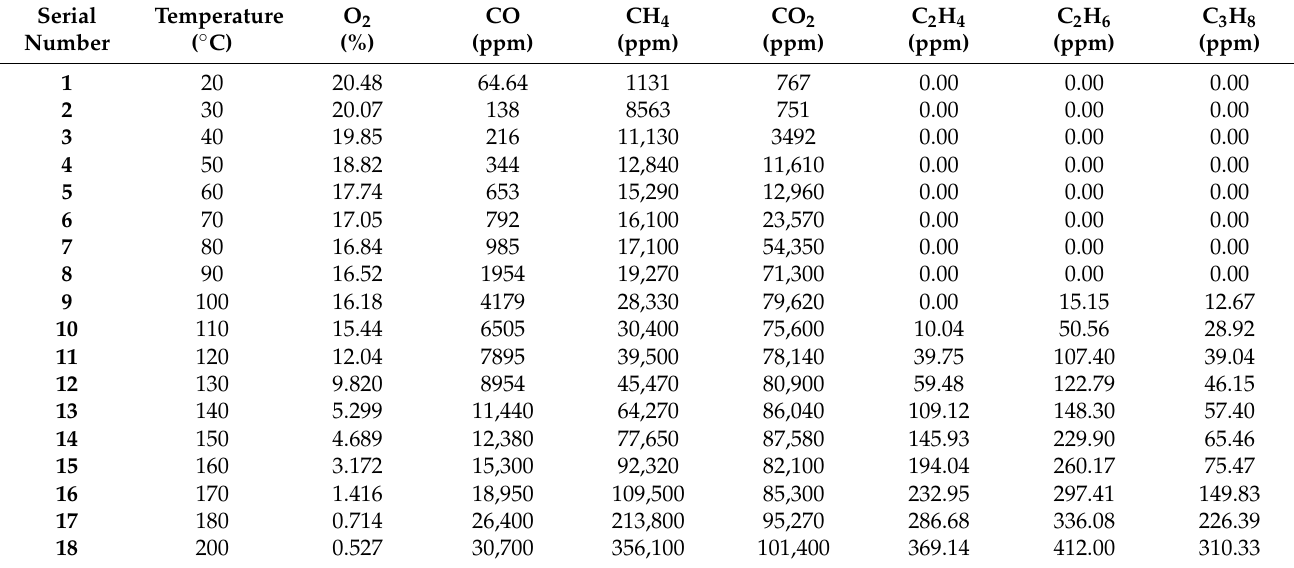
Table 5. Gas concentrations during coal sample heating and oxidation.